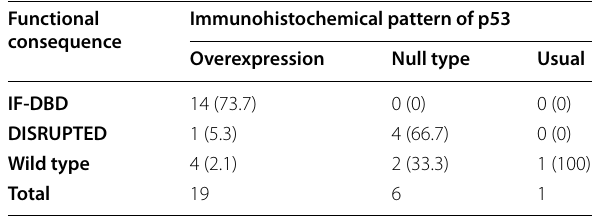
Table 3 Immunohistochemical staining patterns and predicted functional consequence of TP53 mutations Functional consequence